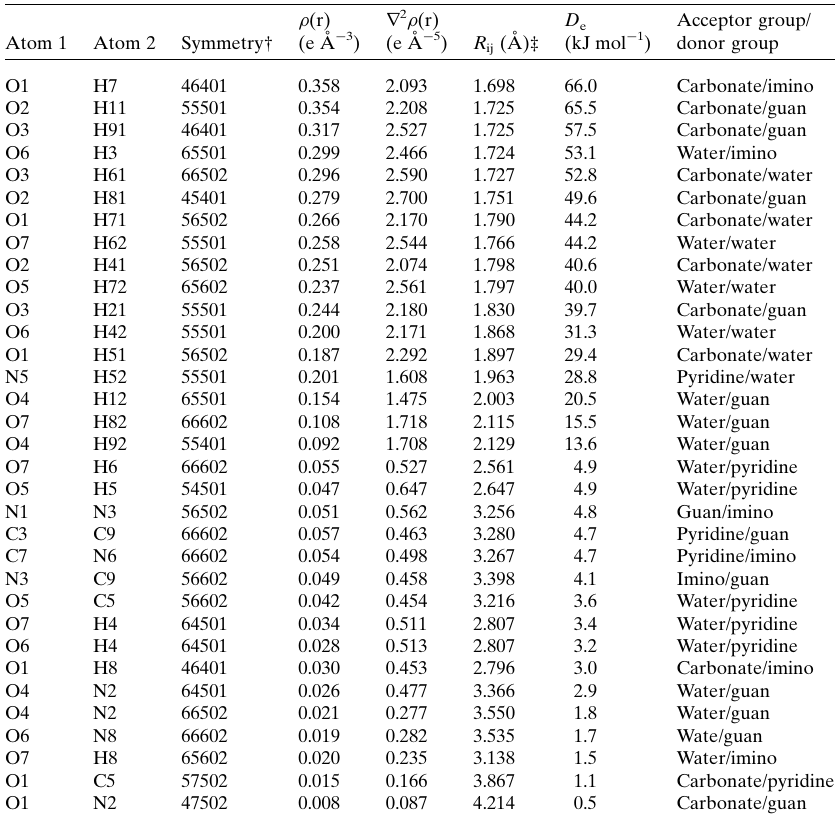
Table 4 Characteristics of bond critical points for closed shell intermolecular interactions. Complete tables of bond critical point properties are provided in the supporting information. Atom 1